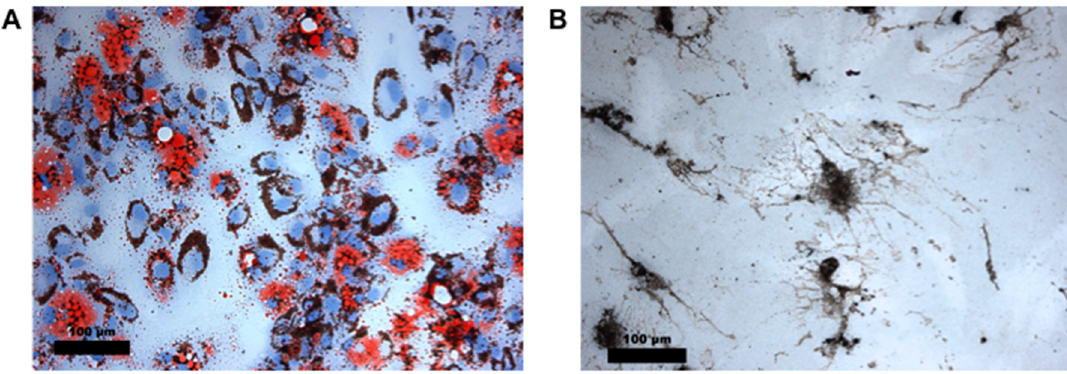
Figure 4. ( A ) hMSC treated with ZnO-NP for 24 h and cultured in adipogenic medium for 1 week. Dark areas in the cell cytoplasm represent ZnO-NP. The adipogenic differentiation was confirmed by staining with Oil Red O to show the presence of intracellular lipid droplets (scale bar representing 100 μ m). ( B ) Microscopic analysis of hMSC cultured in osteogenic medium after ZnO-NP treatment. The van Kossa staining characterizes the mineralization by marking the calcium mineral components (scale bar representing 100 μ m).